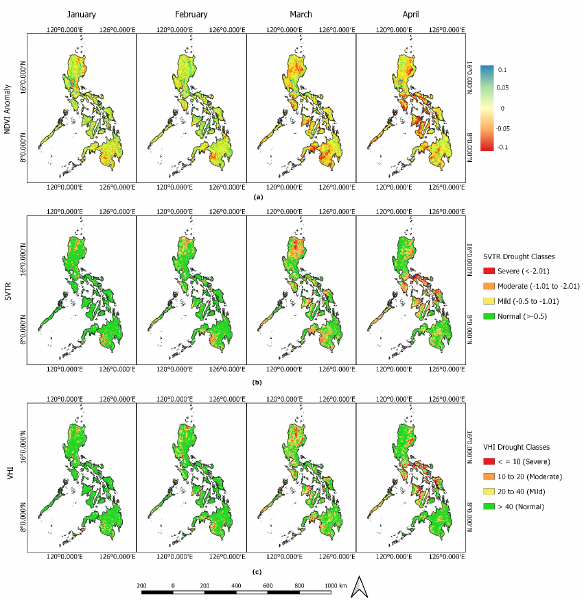
Figure 4. Monthly drought indices derived from MODIS